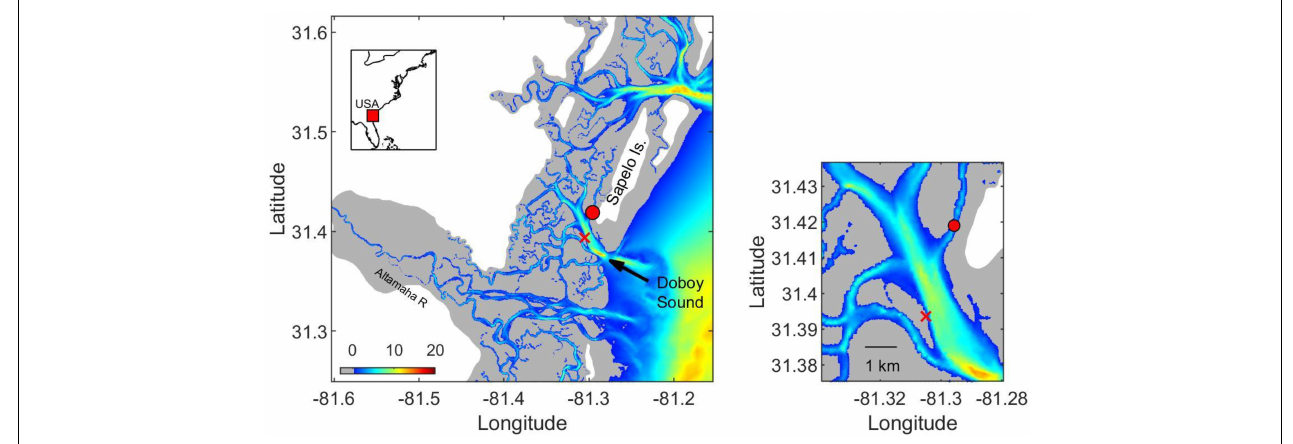
FIGURE 1 | ( left ) Sampling location in Doboy Sound, GA (red circle). Salt marshes and uplands are shown in gray and white, respectively. Colors indicate bottom topography in meters. Location of oceanographic mooring GCE6, where salinity time series was obtained (see Figure 8 ), is shown by red cross. ( right ) Region around sampling site is shown in